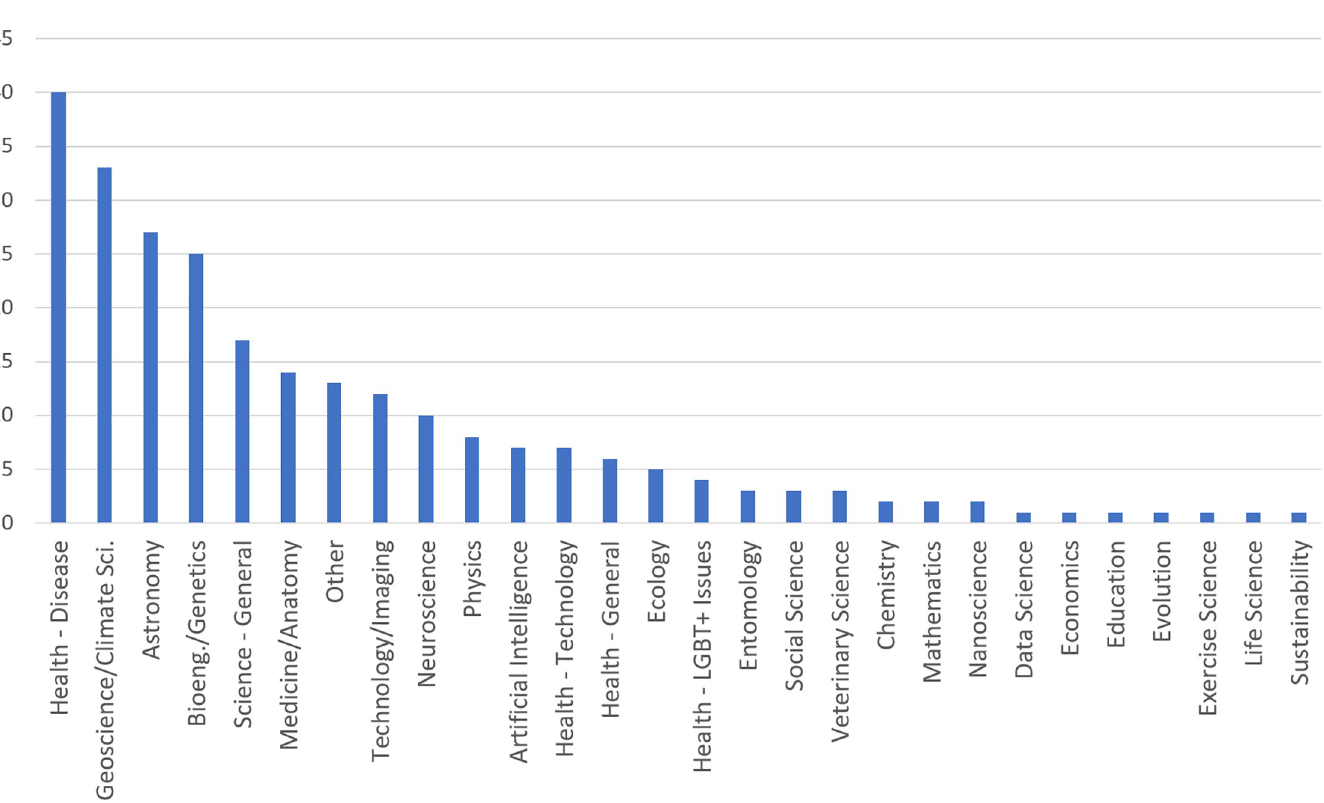
Fig 2. Number of comments by discipline of